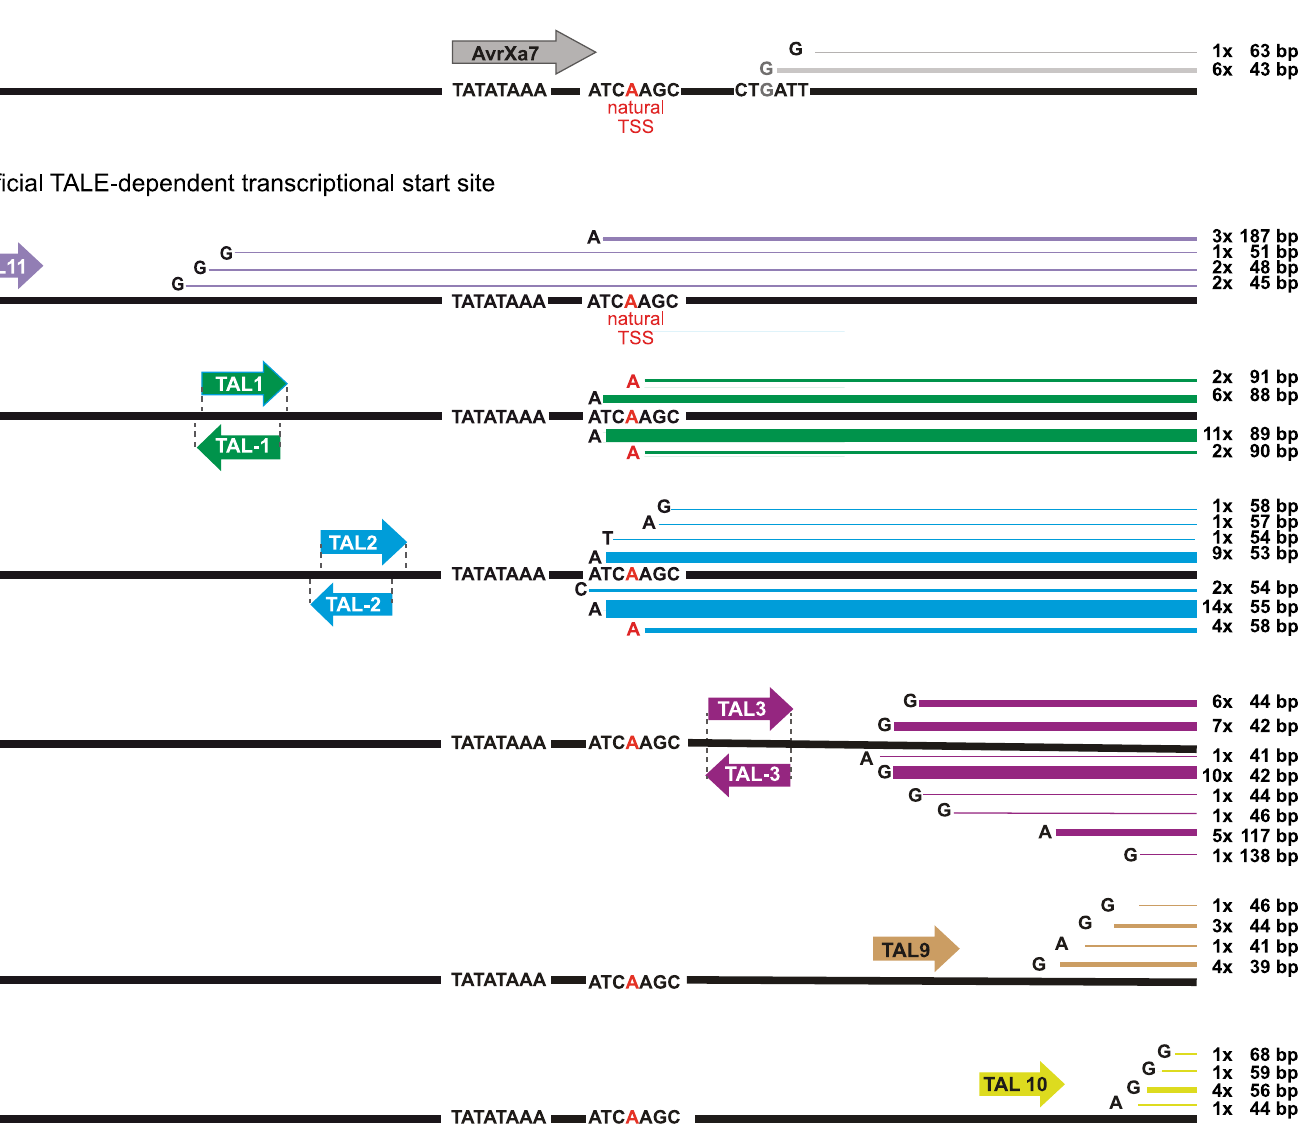
Fig 6. Artificial TALEs do not always shift the natural Transcriptional Start Site (TSS) at the OsSWEET14 promoter in N . benthamiana . Overview of analyzedartificial and natural TALEs that bind to different positions in the OsSWEET14 promoter. The natural OsSWEET14 TSS in rice is marked with a red "A", and the AvrXa7-induced TSS is marked with a grey "G" [20]. Agrobacterium strains deliveringthe 35S -controlledTALE constructs were co-inoculated into N . benthamiana leaves alongwith an Agrobacterium strain deliveringthe reporter construct. 1 dpi leaf discs were harvestedand total RNA was extracted. cDNA was producedand used for 5’ RACE. The first nucleotide of each identified TSS is labeledwith a capital letter. The distanceof the TSS to the 3´end of forward-orientatedTALE target sequencesand to the 5´end of reverse-orientated TALE target sequencesas well as the number of analyzed clones ("x") is indicatedto the right. TSSs that overlapwith the natural OsSWEET14 TSS in rice are marked in